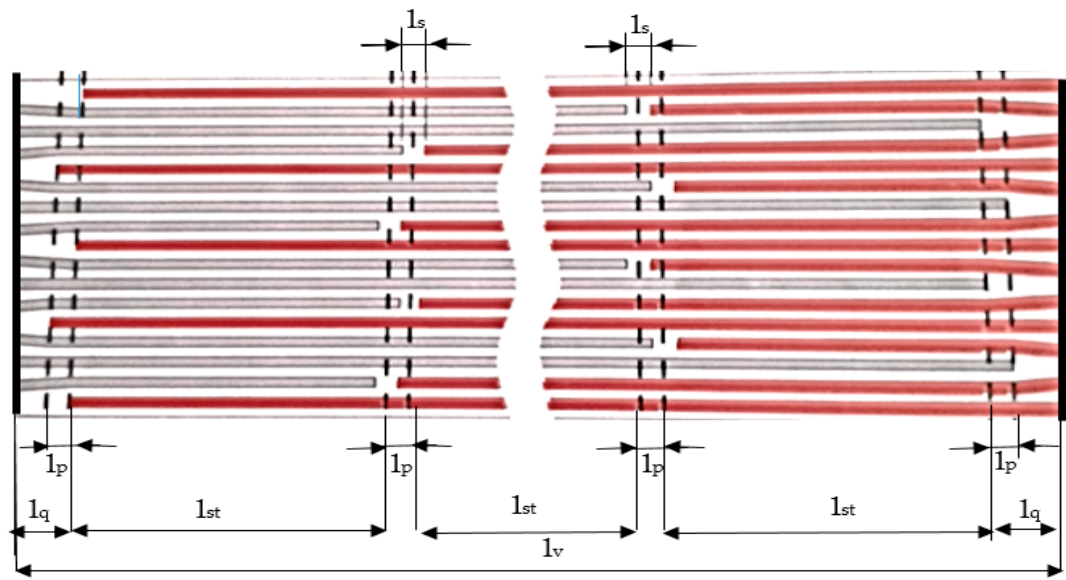
Figure 2. The way of arranging the cables at the vulcanization joint of the conveyor belt.